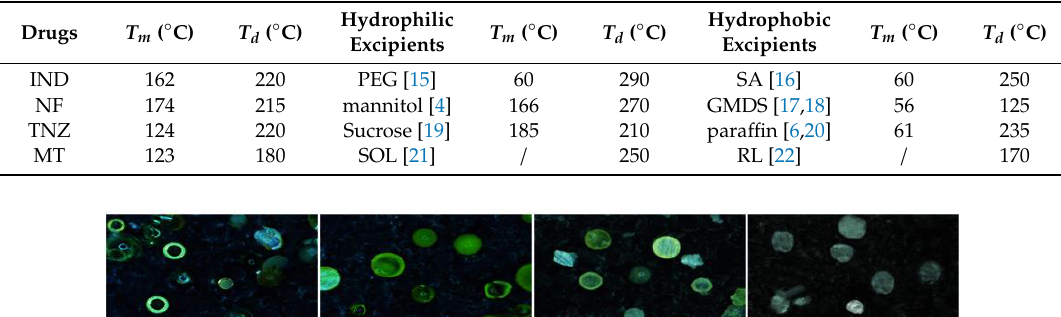
Table 1. Melting temperature ( T m ) and thermal decomposition temperature ( T d ) of drugs (i.e., indomethacin (IND), nifedipine (NF), tinidazole (TNZ), and metoprolol tartrate (MT)), hydrophilic excipients (i.e., polyethylene glycol (PEG), mannitol, sucrose, and Soluplus ® (SOL)) and hydrophobic excipients (i.e., stearic acid (SA), glycerol monostearate/distearate (GMDS), paraffin, and Eudragit ® RL PO (RL)).